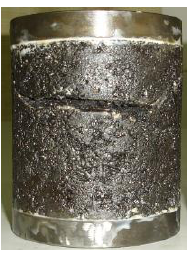
Figure 6. Shear failure.